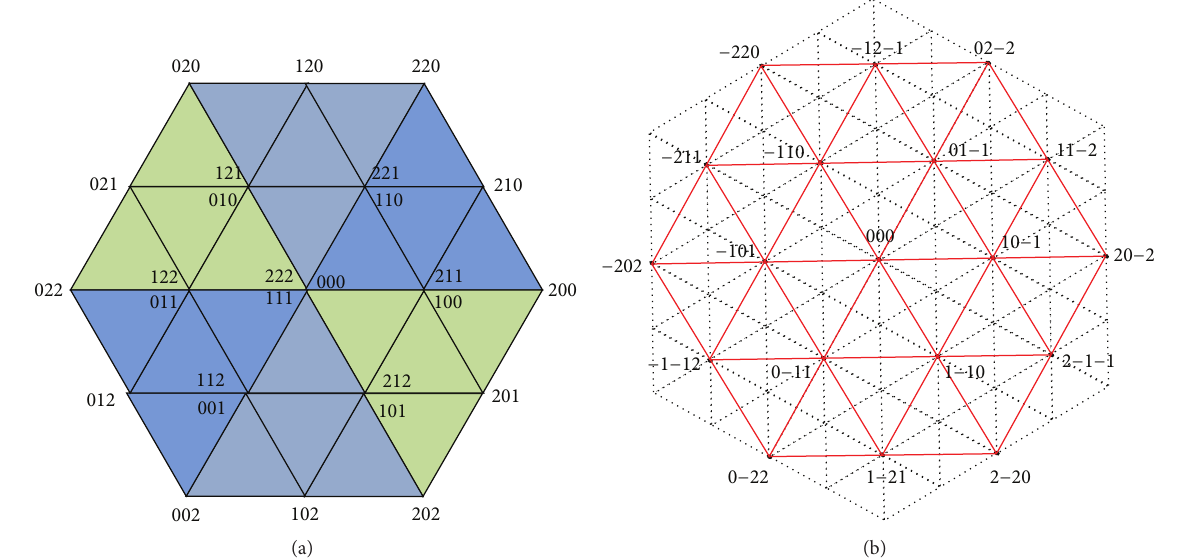
Figure 3: Space vector diagram: (a) three levels and (b) five levels (CMV = 0).